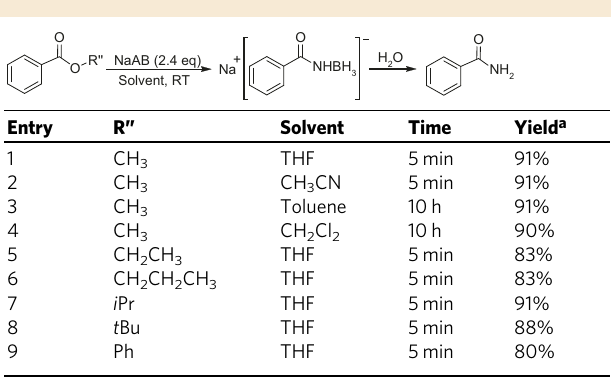
Table 1 Optimization of reaction conditions between NaAB and